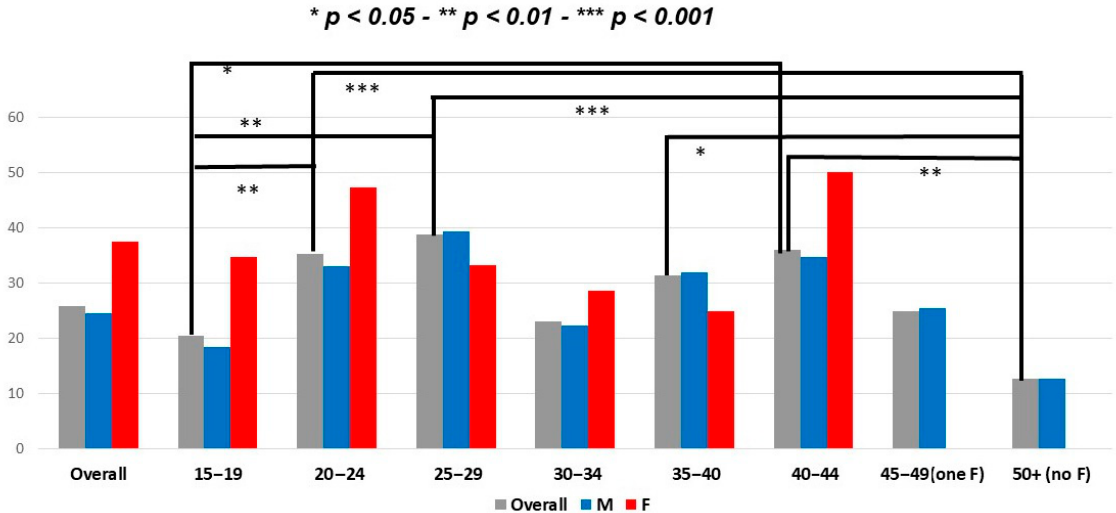
Figure 2. Rate of smokers in the whole study population and according to category of rugby practice and gender. M: male; F: female.